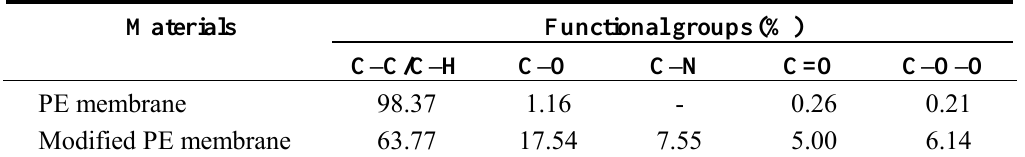
Table 3. XPS analysis of PE and the modified PE membranes. Reproduced with permission from Reference [58]. © 2009 Elsevier Ltd.